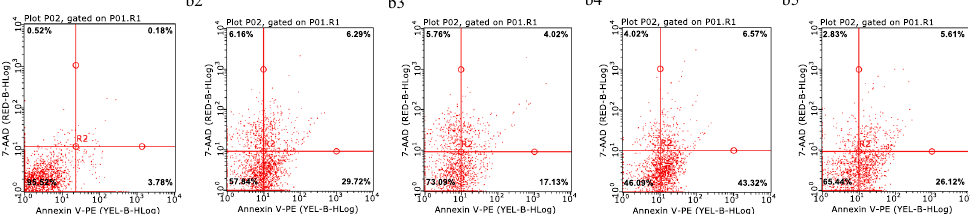
cytometer assay. The normal, early apoptotic, later apop- totic and necrotic cells were respectively distributed on lower left, lower right, upper right and upper left quad- rants of two-dimensional scatter diagram (Fig. 1B). The result of flow cytometer detection showed that the pro- portion of apoptotic cells in UVB group clearly increased, reaching 36.01% and 49.89% at 30 and 120 min after UVB-exposure respectively, compared to 3.96% in nor- mal cells group (NC) as showed in Fig. 1B. In contrast, the apoptotic cells in UVB-JTE group accounted for 21.15% and 31.73% at 30 and 120 min after UVB irradia- tion (Fig. 1B), suggesting that JTE treatment alleviated UVB-induced apoptosis, which is consistent with the results of the MTT assay in this study (Fig. 1A).